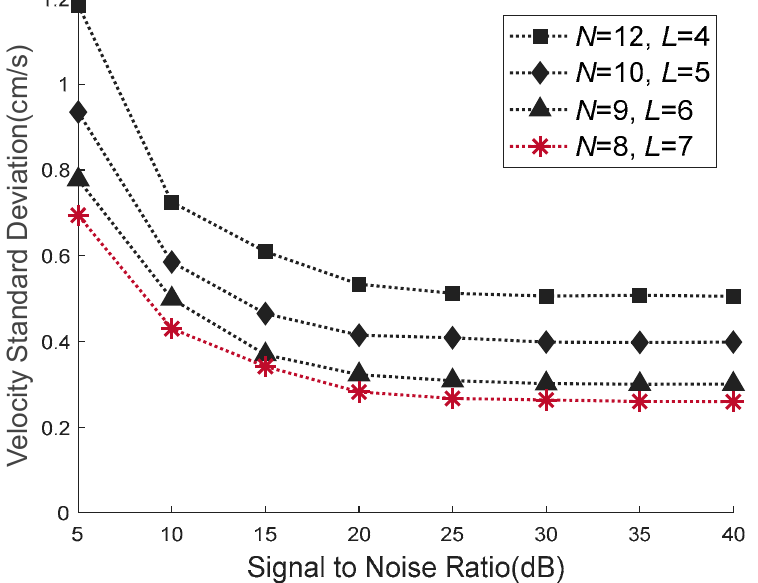
Figure 10. Comparison of the velocity standard deviation between four waveforms. The waveform ( N = 8, L = 7) obtained by the proposed VEAP method achieves the smallest velocity standard deviation.